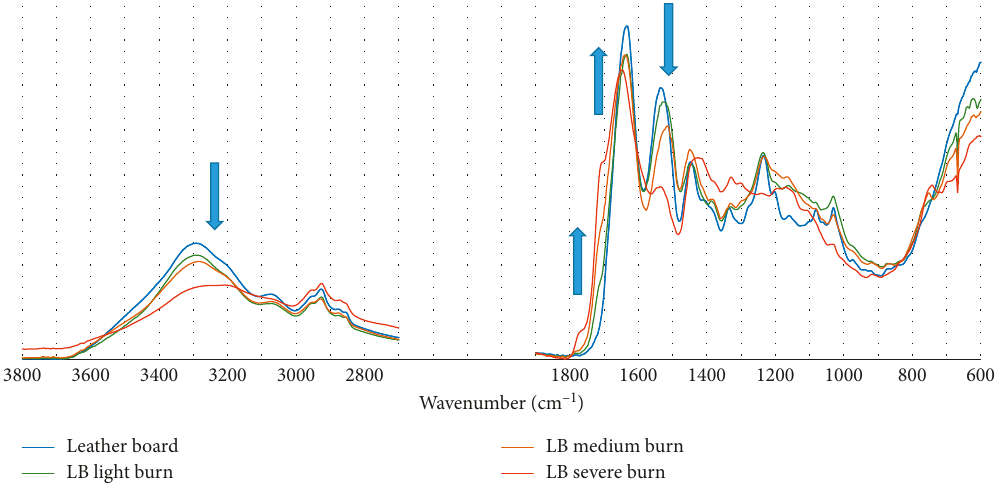
Figure 5: FT-IR spectra of “wet-white” leather after hot-gun test in 4 different positions.